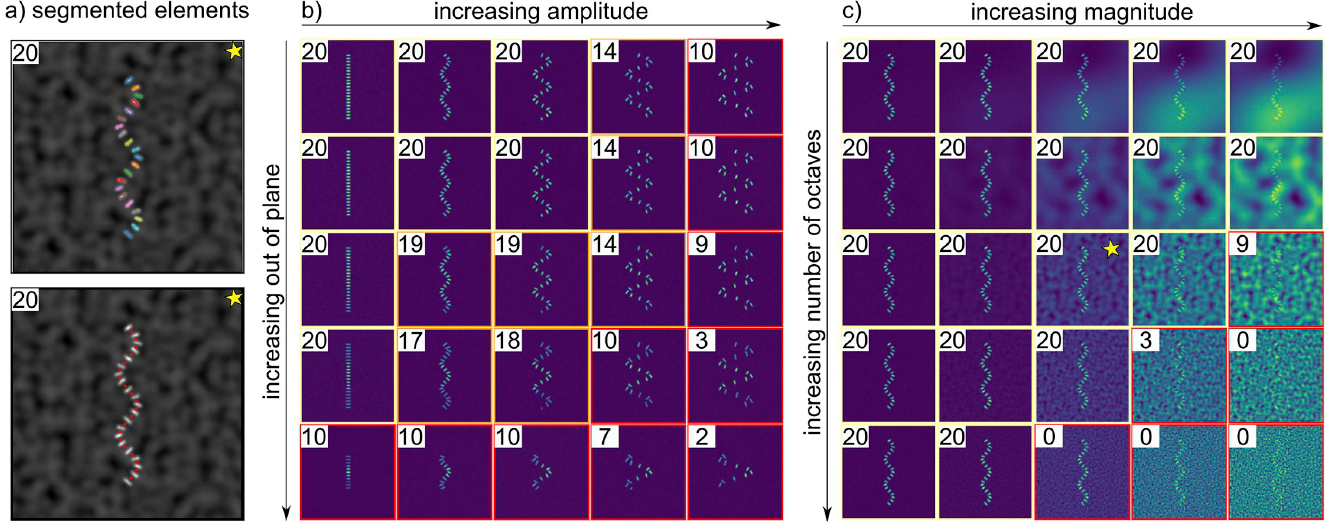
Fig 5. For each image, the number of sarcomeres successfully segmented and tracked (out of 20 possible) is reported. Running the algorithm on synthetic data shows that the code is robust to geometry and noise up to a limit: (a) Illustration of successful z-disc and sarcomere segmentation and tracking for a curved geometry in the presence of noise; (b) Performance degrades when the baseline geometry moves partially out of plane (here slanted in the z-direction), and when the sarcomere chain is too distorted (here high amplitude to period ratio for sinusoidal geometry); (c) Performance degrades in the presence of Perlin noise, in particular noise that is similar in size and brightness to the z-discs